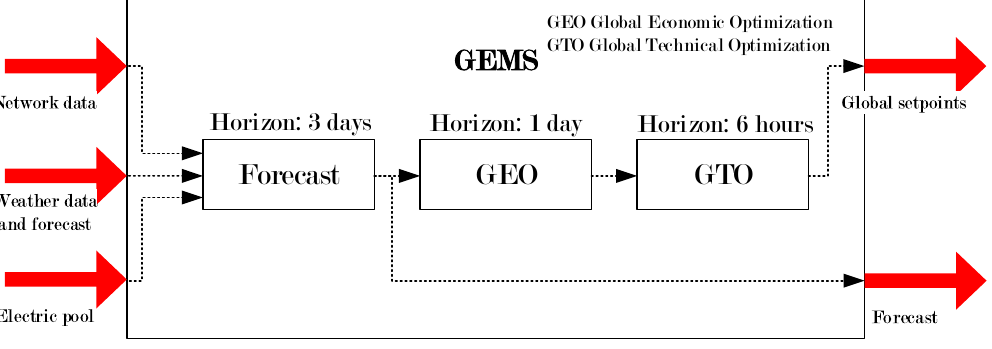
Figure 2. Global Energy Management System (GEMS) in